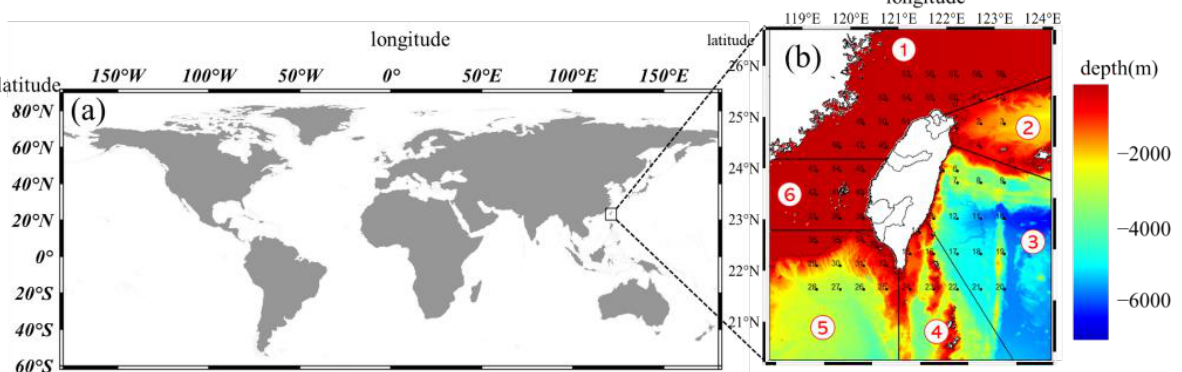
Figure 1. Study areas: ( a ) Taiwan’s location on a world map. ( b ) The study area includes stations (black points) and sea areas (separated by solid black lines and marked with red numbers in white circles) around Taiwan from 2007 to 2019. The black dashed lines indicate contours with depths of 200 m and bathymetry. The areas were defined as follows: the northwestern (area 1), northeastern (area 2), southeastern (area 3), southern (area 4), southwestern (area 5), and Penghu island (area 6) regions. Table 1. Codes and habitat depth zones of 38 major species of fish (larvae and juveniles) in the waters around Taiwan from 2007 to 2019. The depth zones of different fish species are listed according to the classification methods of Sassa and Konishi [25] and Chen, Chen, Wang and Lee